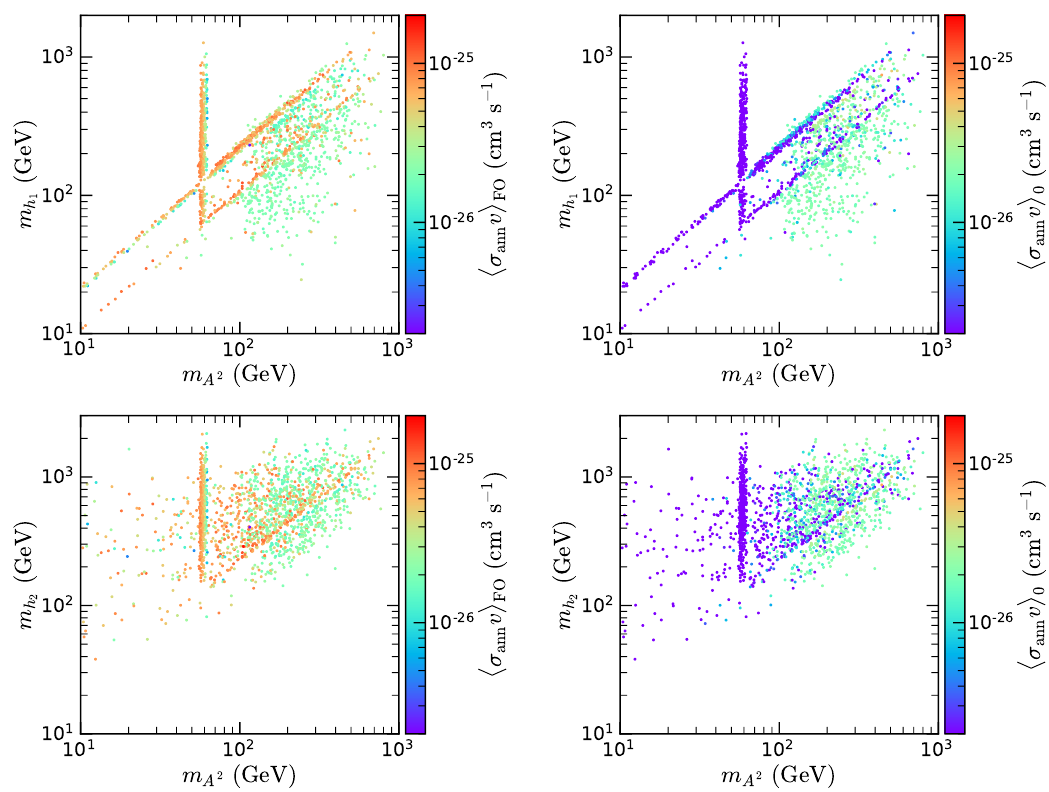
Figure 5. h σ ann v i FO (left panels) and h σ ann v i 0 (right panels) for the surviving parameter points projected in the m